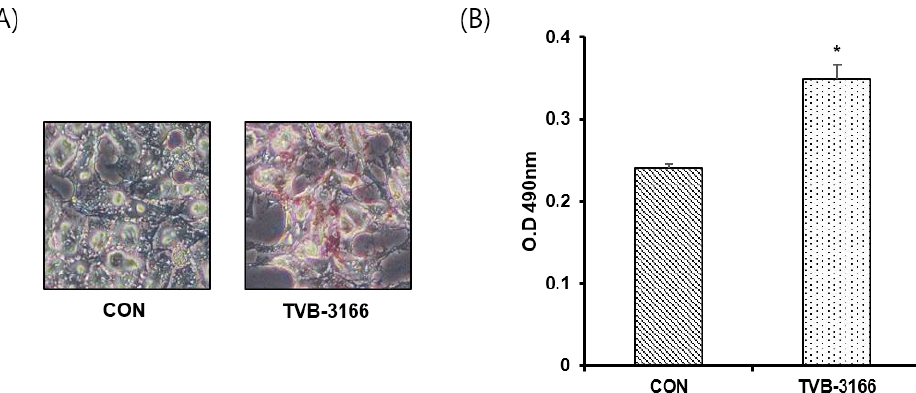
Figure 6. Quantitative Oil-Red O staining of LNCaP_LN3 cells. LNCaP_LN3 cells were treated with 50 μM of TVB-3166 in fatty acid-free media for 24 h, then stained using the optimized protocol (see Materials and Methods). ( A ) Representative images of untreated (CON) and TVB-3166 treated cells. ( B ) Quantitative evaluation of staining in untreated and TVB-3166 treated cells. *, p < 0.05 by Student’s t -test.